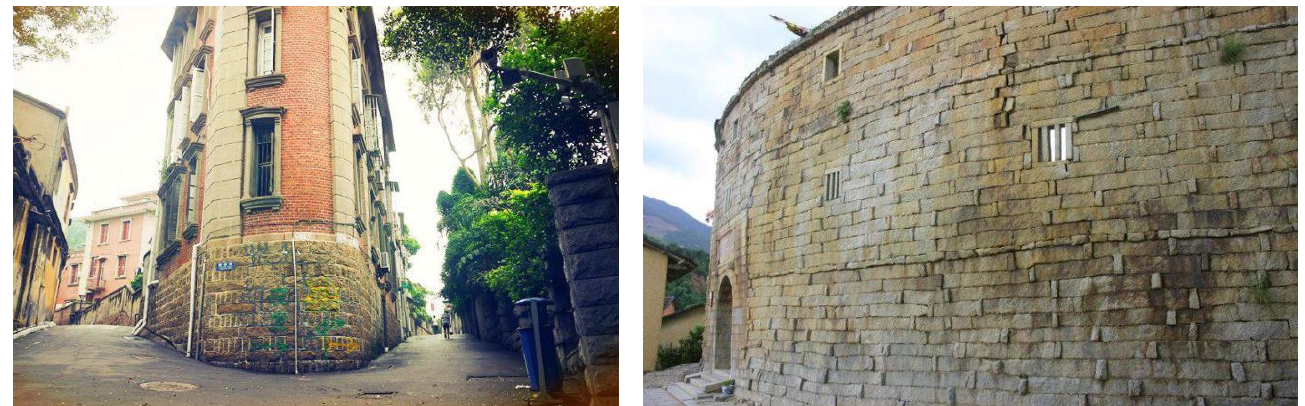
Figure 1. Stone masonry structure in an actual building.